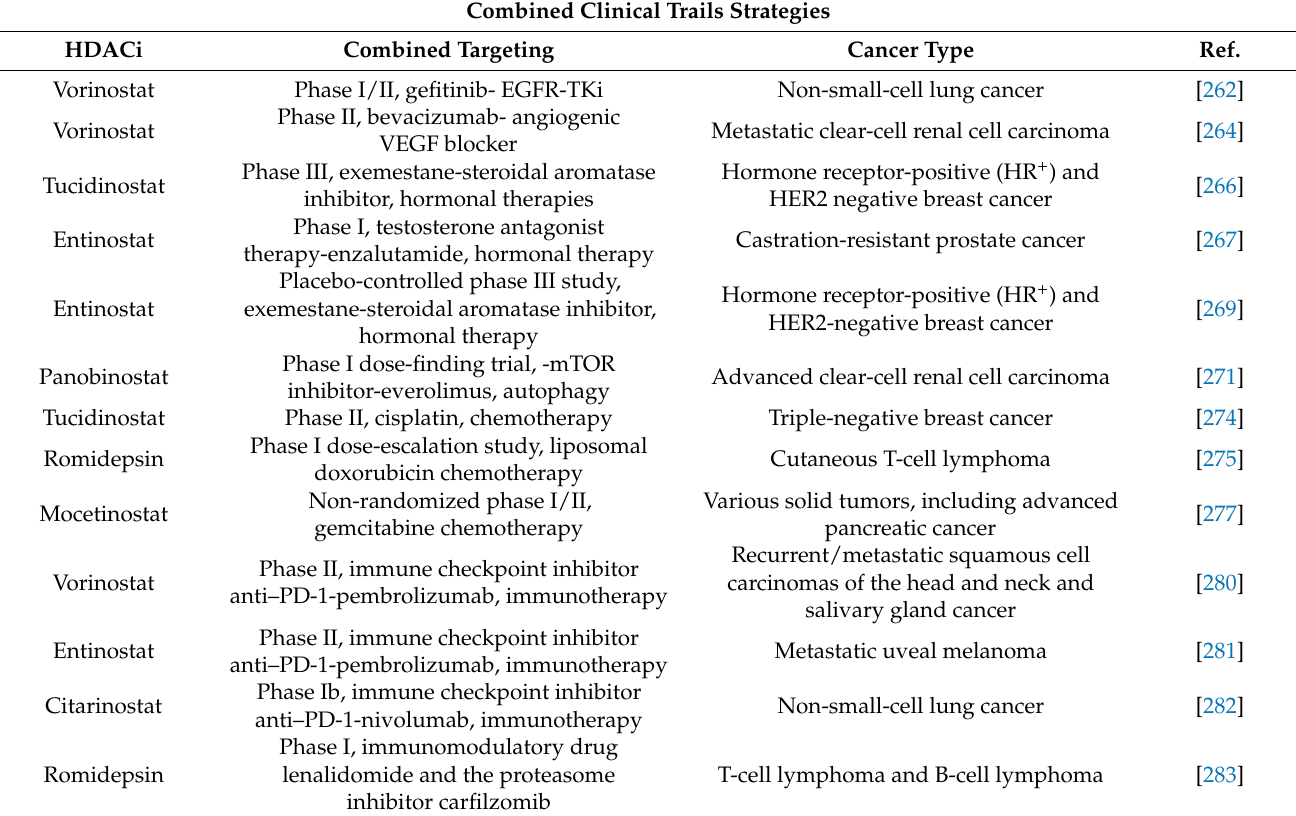
Table 6. Selected histone deacetylase inhibitors in combined clinical trials. TKi: tyrosine kinase inhibitors; PD-1; programed cell death